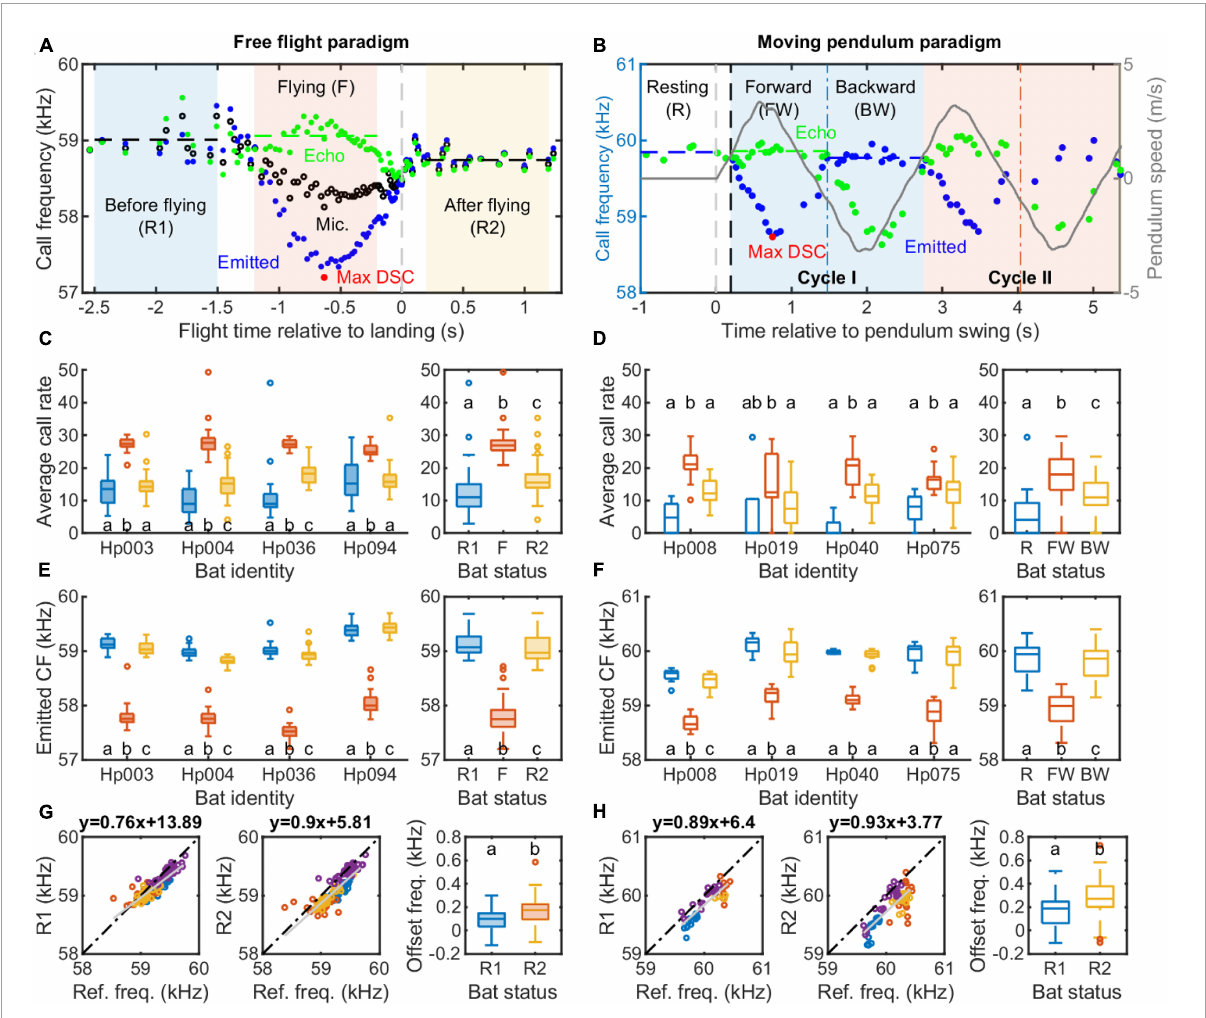
FIGURE5 Vocal behavior of Hipposideros pratti in the free flight and moving pendulum paradigms. (A) A detailed illustration of the DSC behavior of a flying bat. For quantitative analyses, a flying trial was divided into three one-second sections: before flying (R1; –2.5 ∼ –1.5 s), during flying (F, –1.2 ∼ –0.2 s), and after flying (R2; 0.2 ∼ 1.2 s). Time was referred to as the median of the landing time estimated by the vocal behavior when the bat reached the maximum call rate, minimum call amplitude, and call duration ( Figure 2B ; see section “Materials and methods” for more